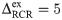
Delayed inhibitory feedback sharpens the temporal frequency tuning of relay cells, while delayed excitatory feedback blunts the temporal frequency tuning of relay cells.Effect of cortical feedback on temporal frequency tuning of relay cells are shown for different values of thalamocortical delay. Panel A: inhibitory feedback only. Panel B: excitatory feedback only. Panel C, left: delayed inhibition, i.e., rapid excitatory feedback combined with long-delay inhibitory feedback (ΔRCRex=5 ms, ΔRCRin=30 ms). Panel C, center: synchronized feedback, i.e., excitatory and inhibitory feedback arrive simultaneously (ΔRCRex=ΔRCRin=15 ms). Panel C, right: delayed excitation, i.e., long-delay excitatory feedback combined with rapid inhibitory feedback (ΔRCRex=30 ms, ΔRCRin=5 ms). Full-field grating is used as stimulus (|kg| ≈ 1deg−1) and default values from Table 1 is used for fixed parameters.